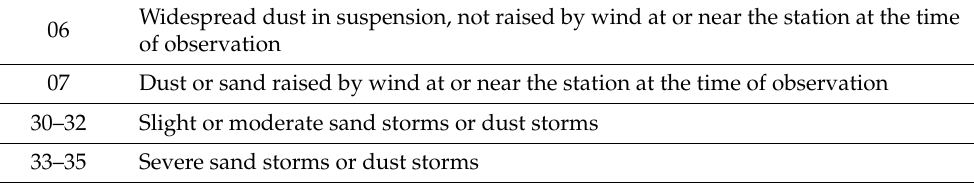
Table 2. The dust-related present weather